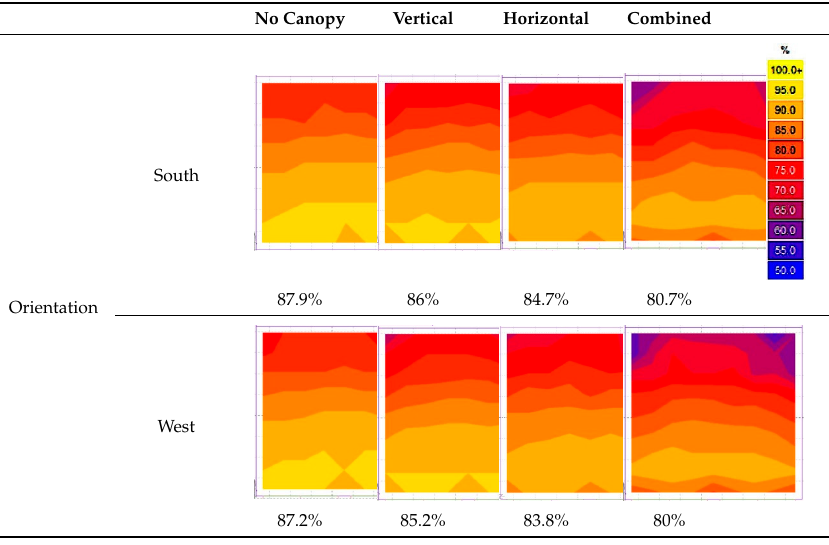
Table 5. Daylight Autonomy (DA) in the classroom with different shading devices.